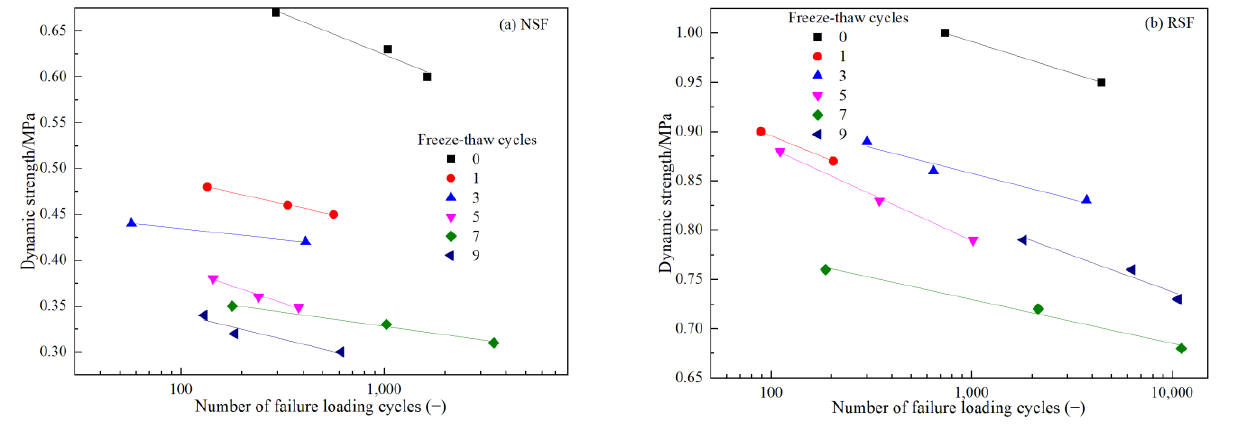
Figure 7. Curves of dynamic strength and failure vibration numbers ( a ) for NSF, ( b ) for RSF.